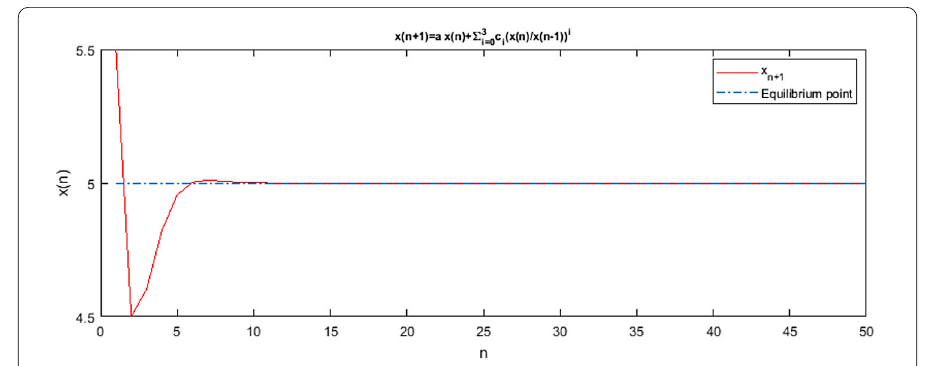
Figure 3 Stable solution of difference equation (4.1)